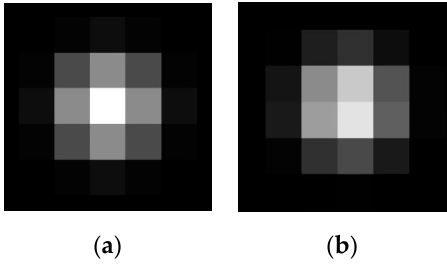
Figure 2. Degraded images of point sources when phases of point sources are (0, 0) ( a ) and (0.6, 0.8) ( b ).